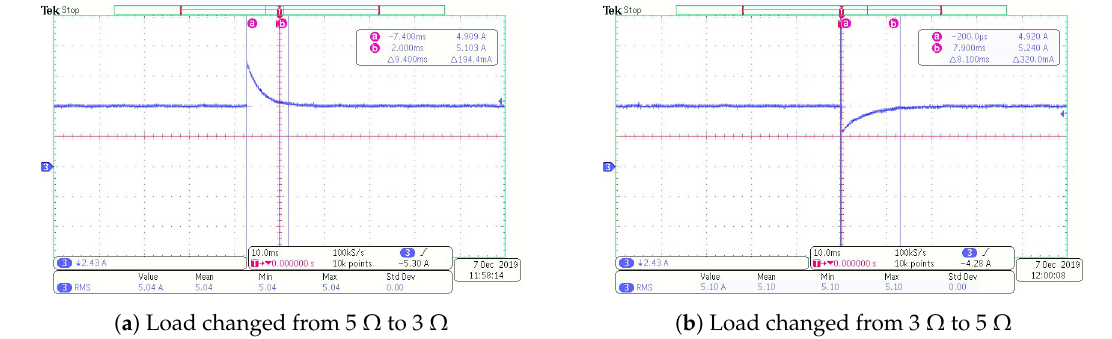
Figure 19. Tracking of constant current.